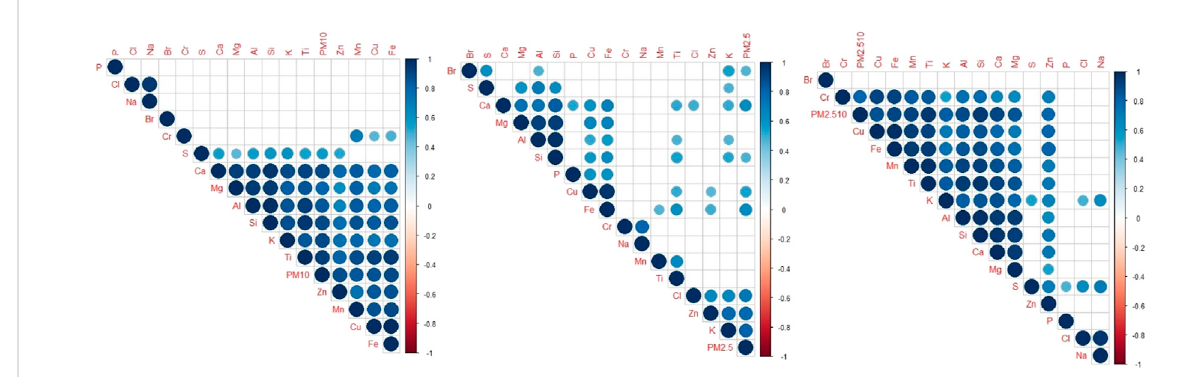
FIGURE 7 Results ofcorrelationanalysisoftheconcentrationofchemical elementsinPMobtained duringmeasurementsinthePova ž ský